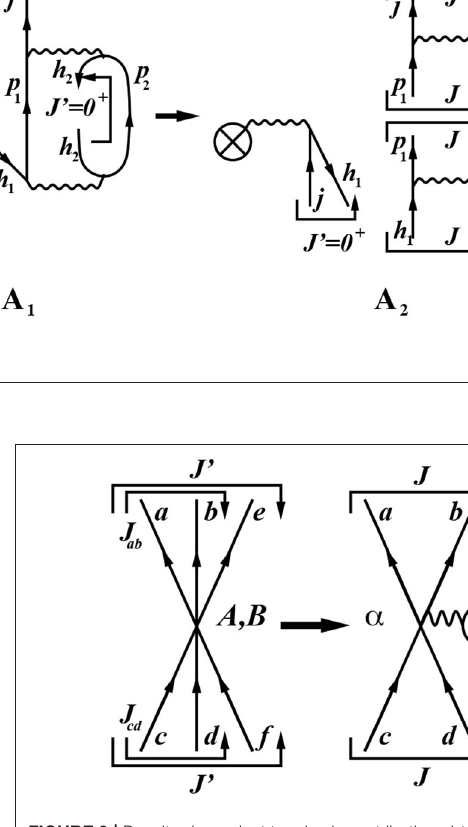
FIGURE 9 | Density-dependent two-body contribution obtained from a three-body one; α is obtained by summing over one incoming and one outgoing particle of the three-body graphs A in Figure 8